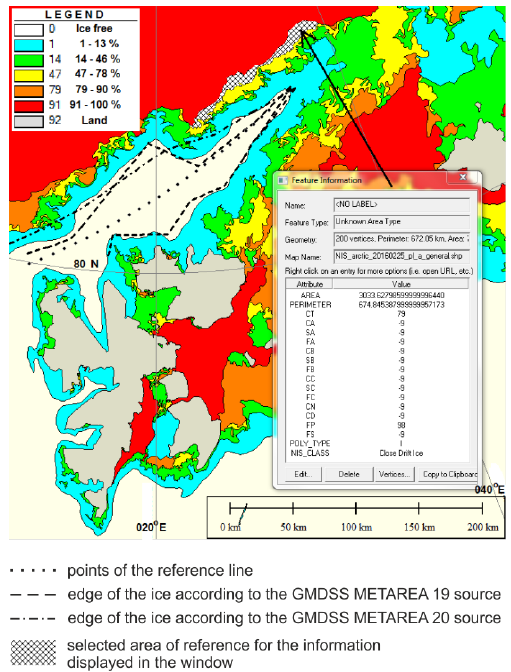
Fig. 3. The map of sea ice of the